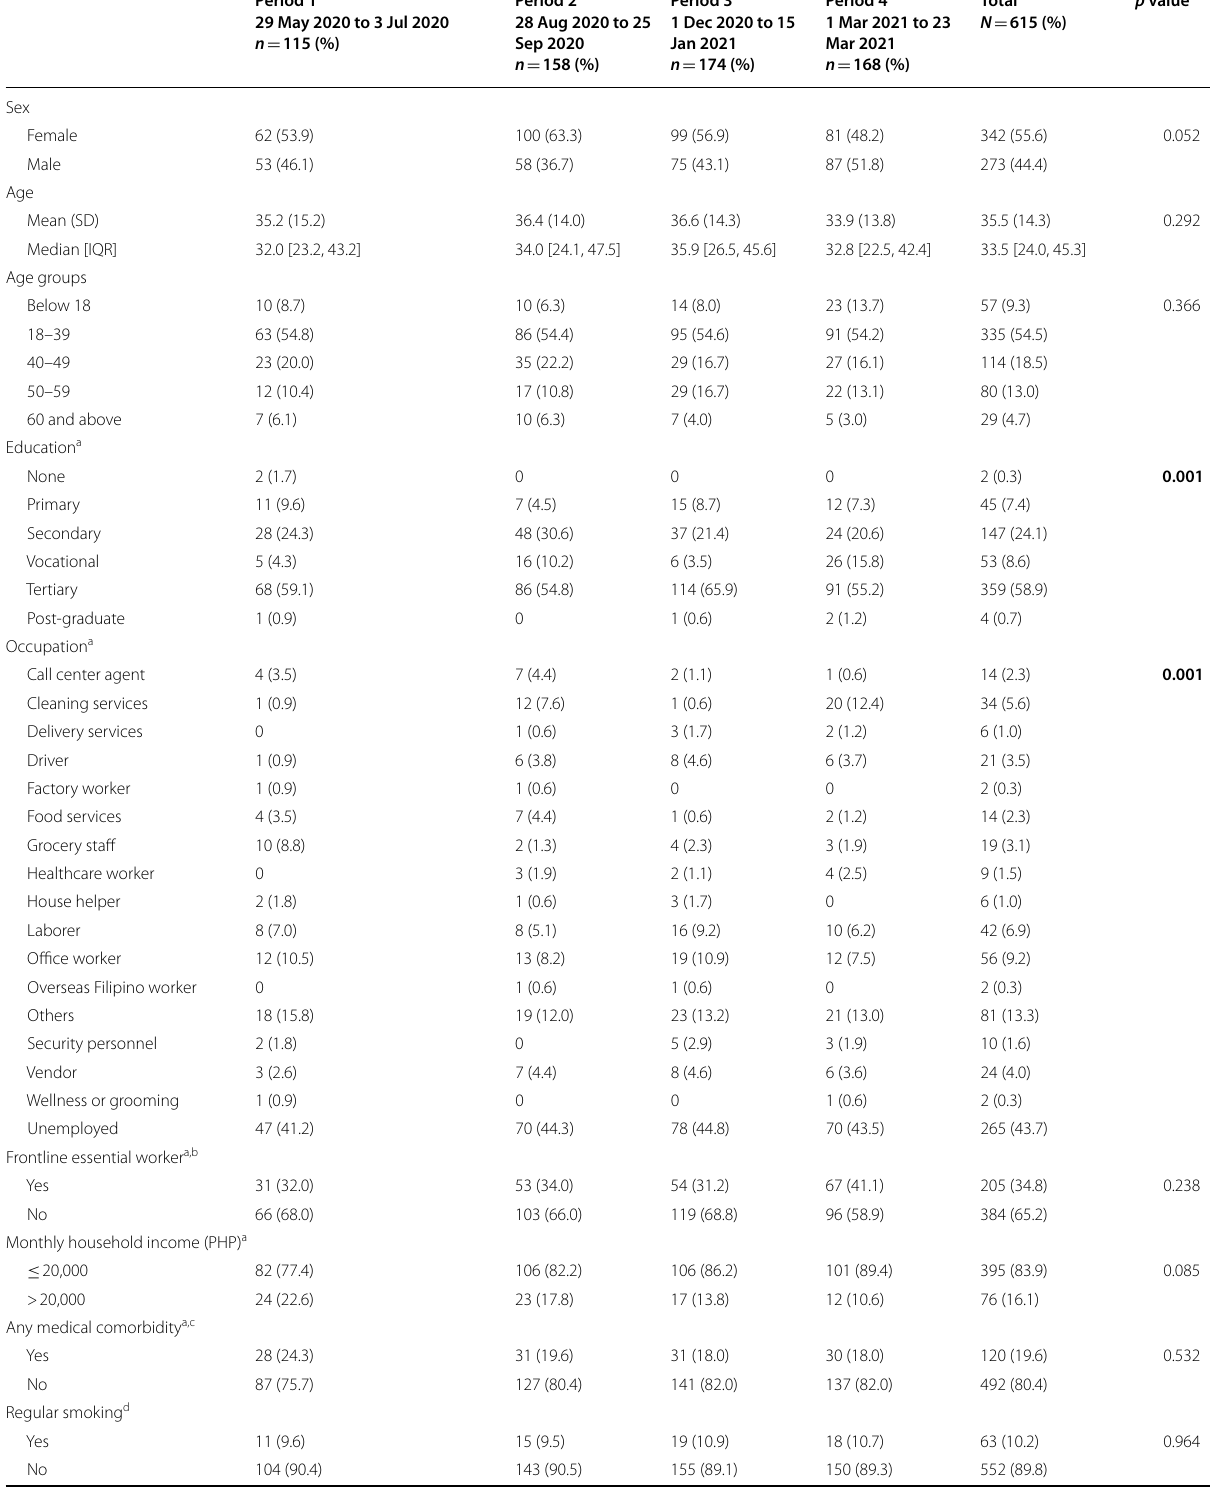
Table 1 Participant characteristics stratified by data collection